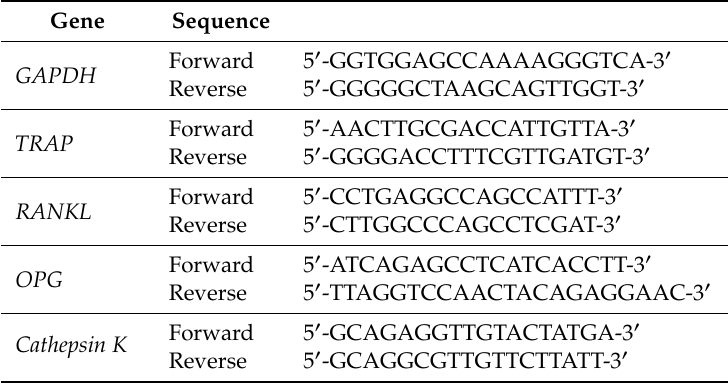
Table 1. Primers used for real-time